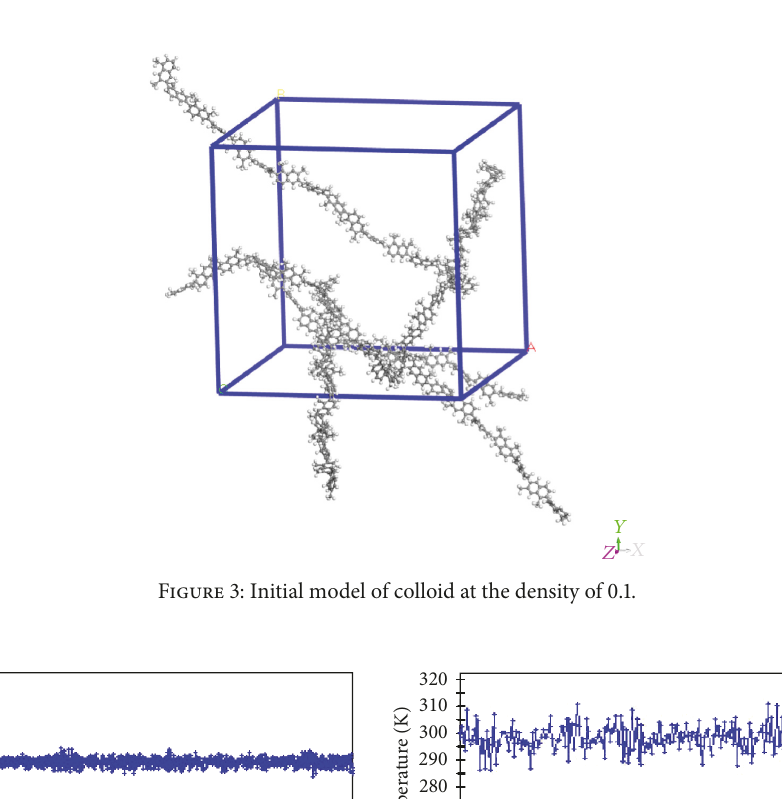
Figure 2: Long chain of colloid after being geometrically optimized.